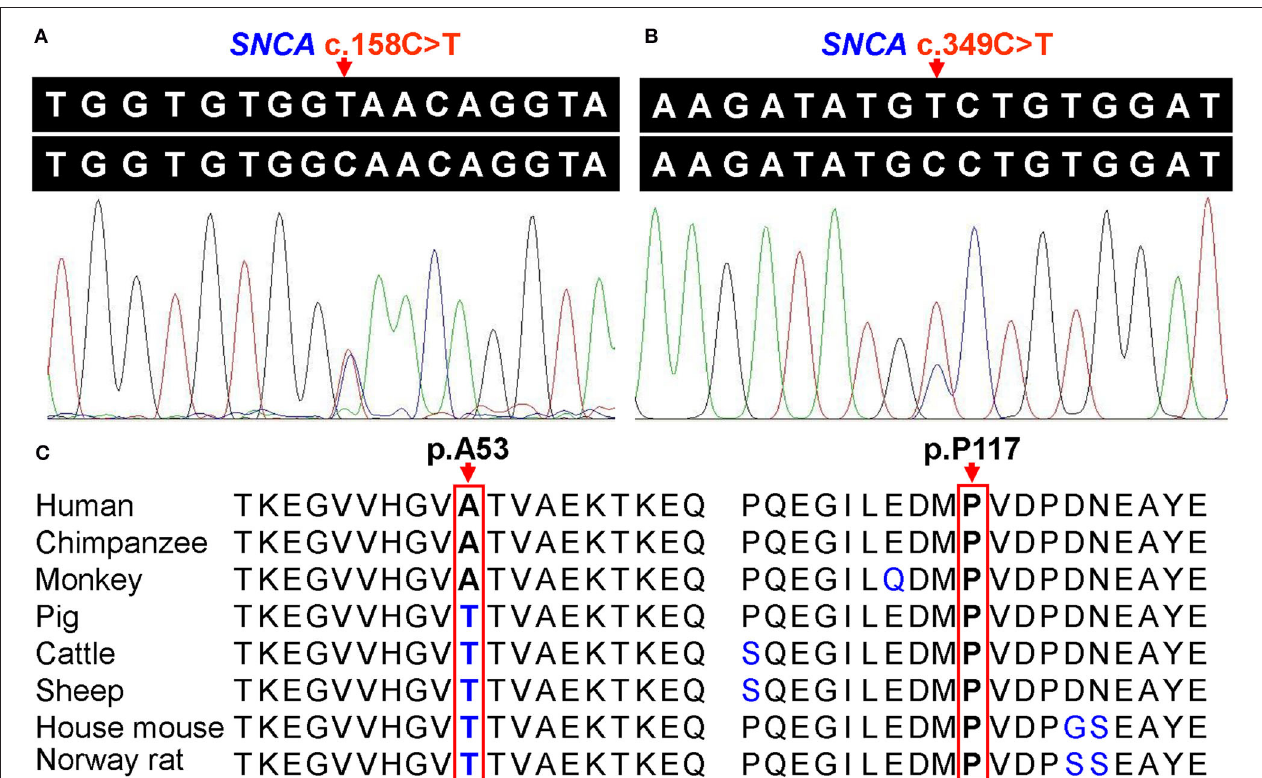
FIGURE 1 | (A) Sanger sequencing of heterozygous SNCA c.158C > T (p.A53V) variant. (B) Sanger sequencing of heterozygous SNCA c.349C > T (p.P117S) variant. (C) Conservation analysis of alpha-synuclein protein, and arrows indicate the amino acid residues at positions 53 and 117, respectively.